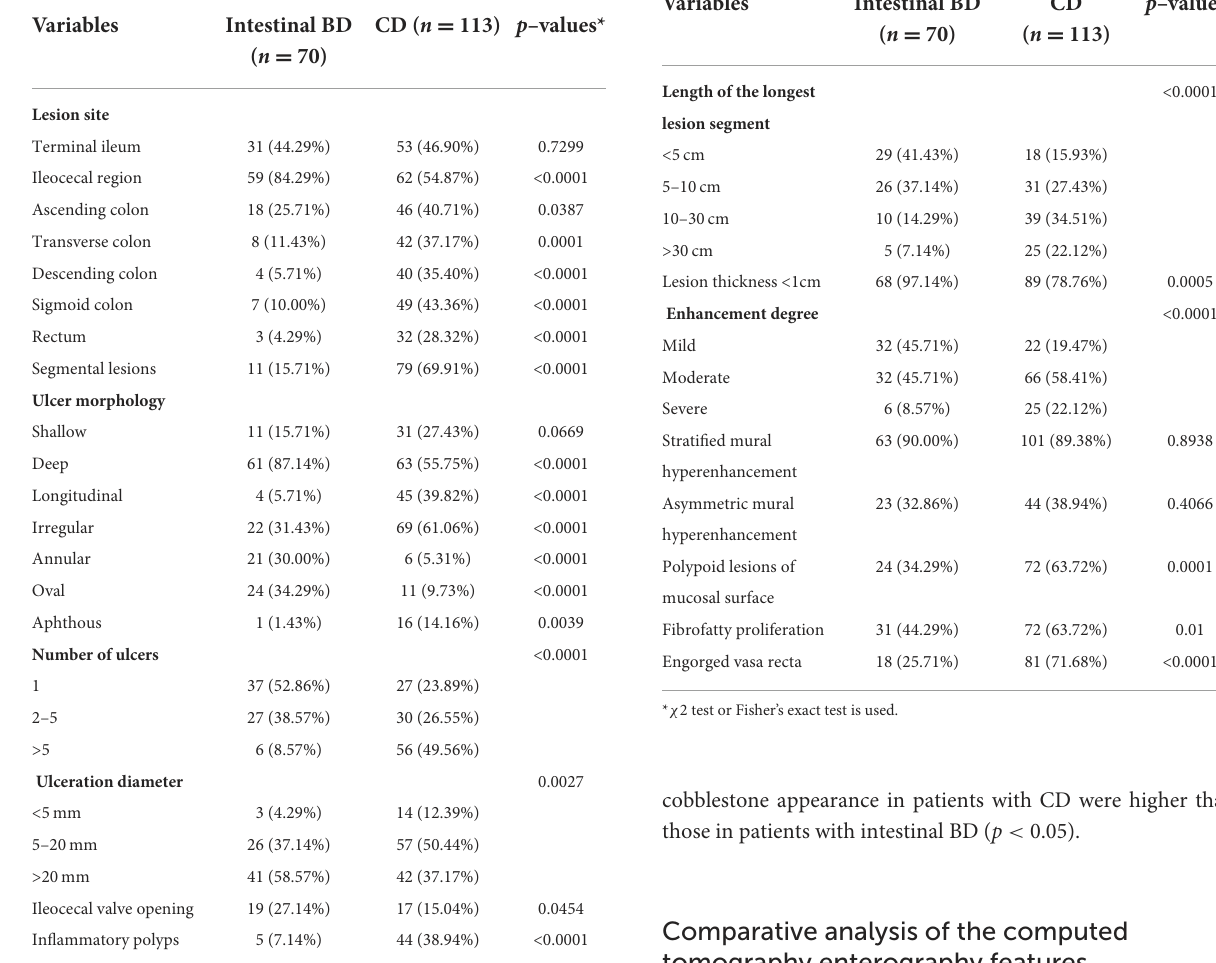
TABLE 4 Endoscopic characteristics of participants with CD or intestinal BD.